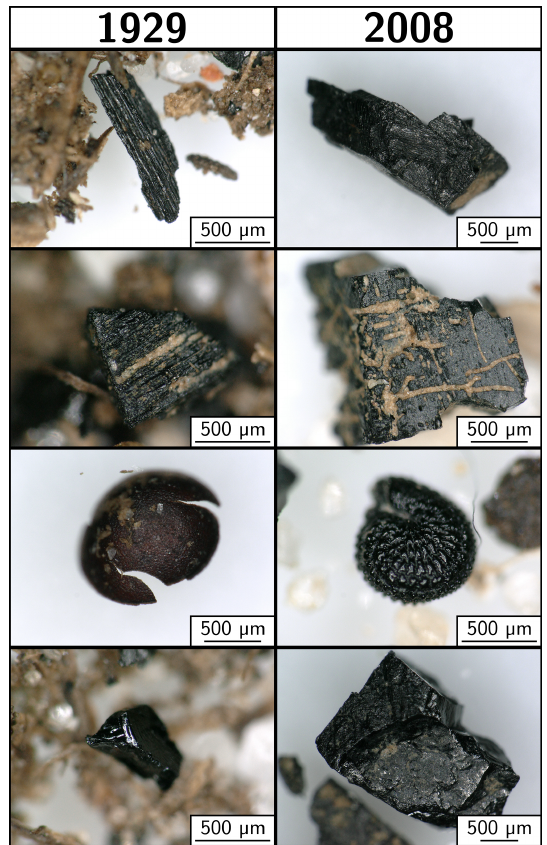
Figure 6. Optical microscope photographs showing the typical structure and morphology of the PyOC grains analysed by Raman spectroscopy in the sand